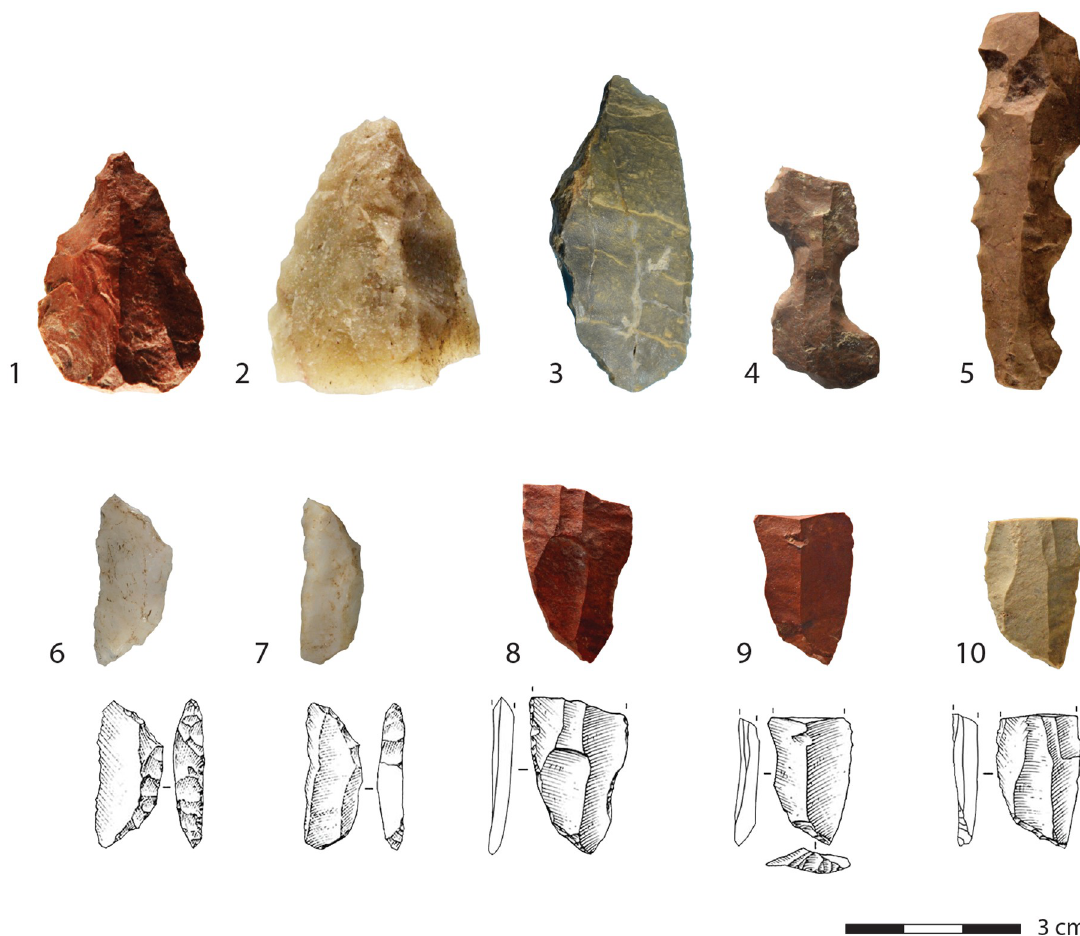
Fig 8. Examples of tools from the HP sequence of KDS. 1–2: PAY; 3: PAZ; 4,8: PBE; 5,7: PBC; 6: PBA/PBB; 9–10: PCA. 1,3,4,5,8,9,10: Silcrete; 2: Quartzite; 6–7: Quartzite. Drawings by Gauthier Devilder after